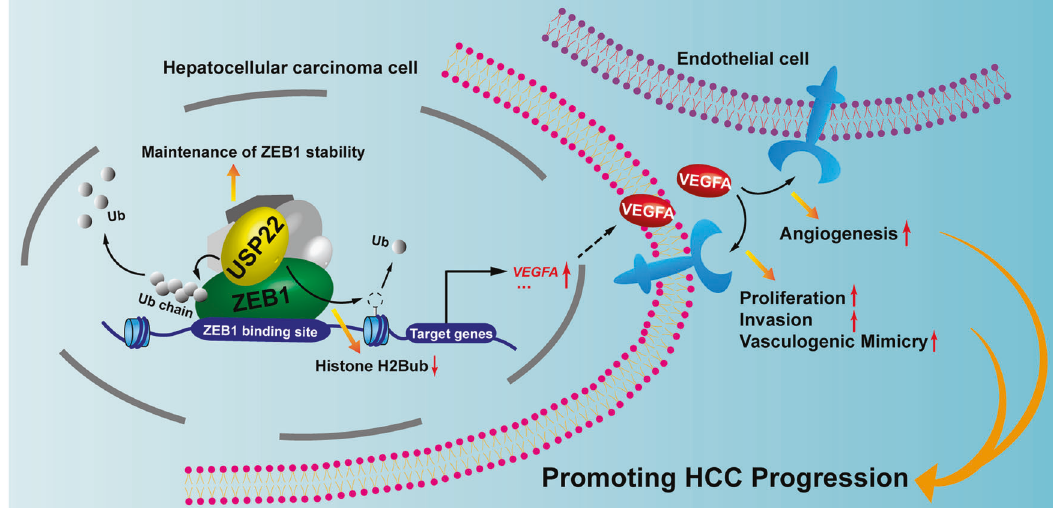
Fig. 8 Schematic diagram illustrating the function of USP22 on modulation of ZEB1-induced VEGFA transcription and the role of USP22 in promotion of HCC progression. USP22 maintains ZEB1 stability by triggering deubiquitination of ZEB1. USP22/ZEB1 being recruited to the ZEB1 binding elements of VEGFA promoter region, inducing the ubiquitination of histone H2B, enhances the transcription of VEGFA .This effect ultimately leads to increased expression and secretion of VEGFA, which may accelerate HCC